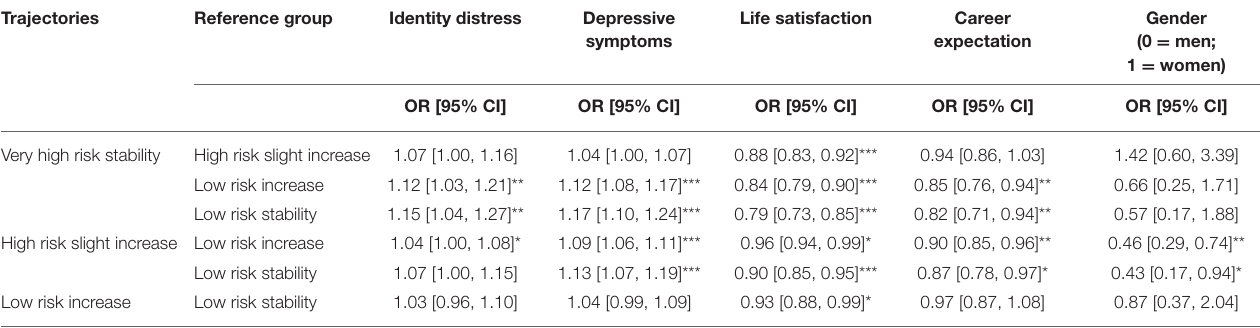
TABLE 6 | Analyses of multinomial logistic regression on trajectories of hikikomori symptoms.